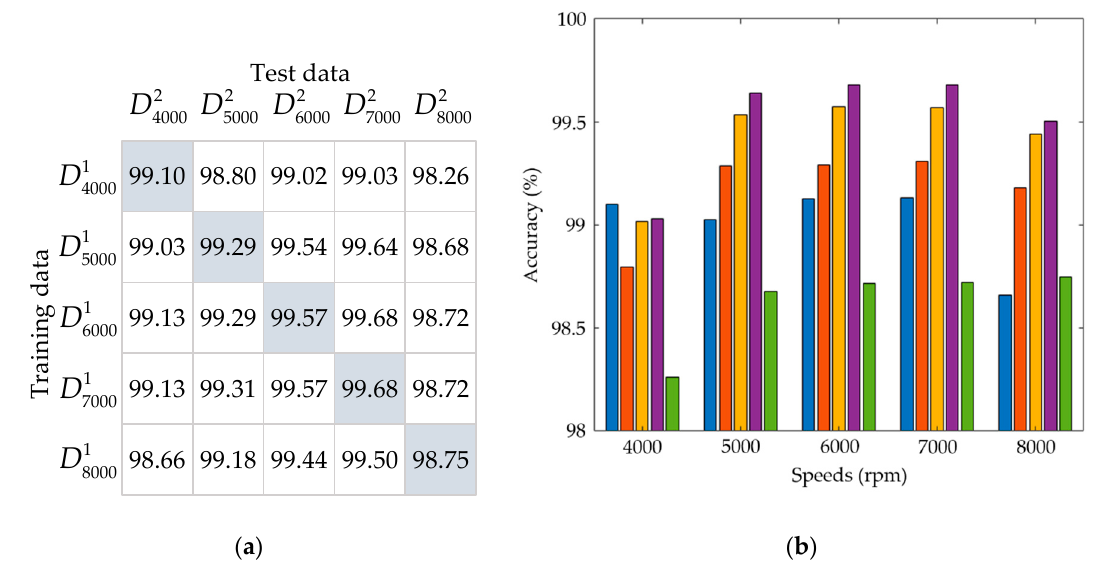
Figure 16. The percentage VA of the 8-order model: ( a ) The matrix chart; ( b ) The bar chart, wherein each group of bars corresponds to a row of the matrix chart.